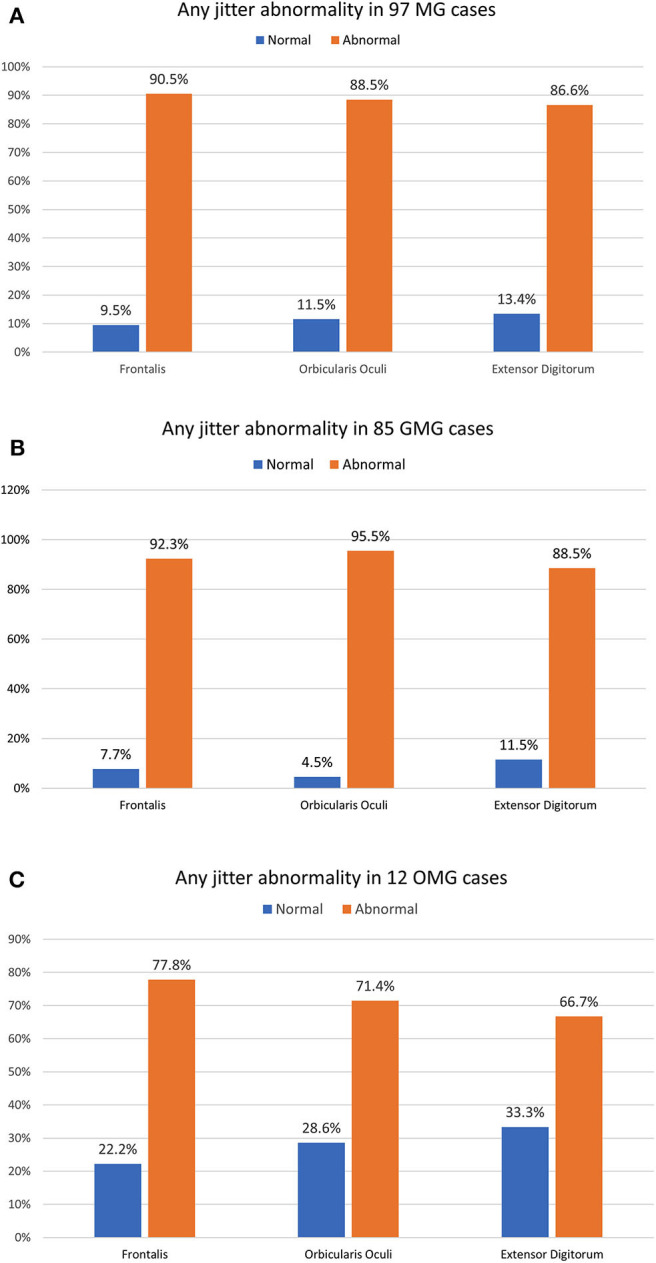
The percentage of any jitter abnormality parameter in three individually muscles for 97 myasthenia gravis (MG) cases (A), 85 generalized MG cases (B), and 12 ocular MG cases (C). The OMG jitter abnormality only reached the 100% abnormality with the combination of the Frontalis and the Orbicularis Oculi muscle. The GMG jitter abnormality was very high, even in just one muscle studied.